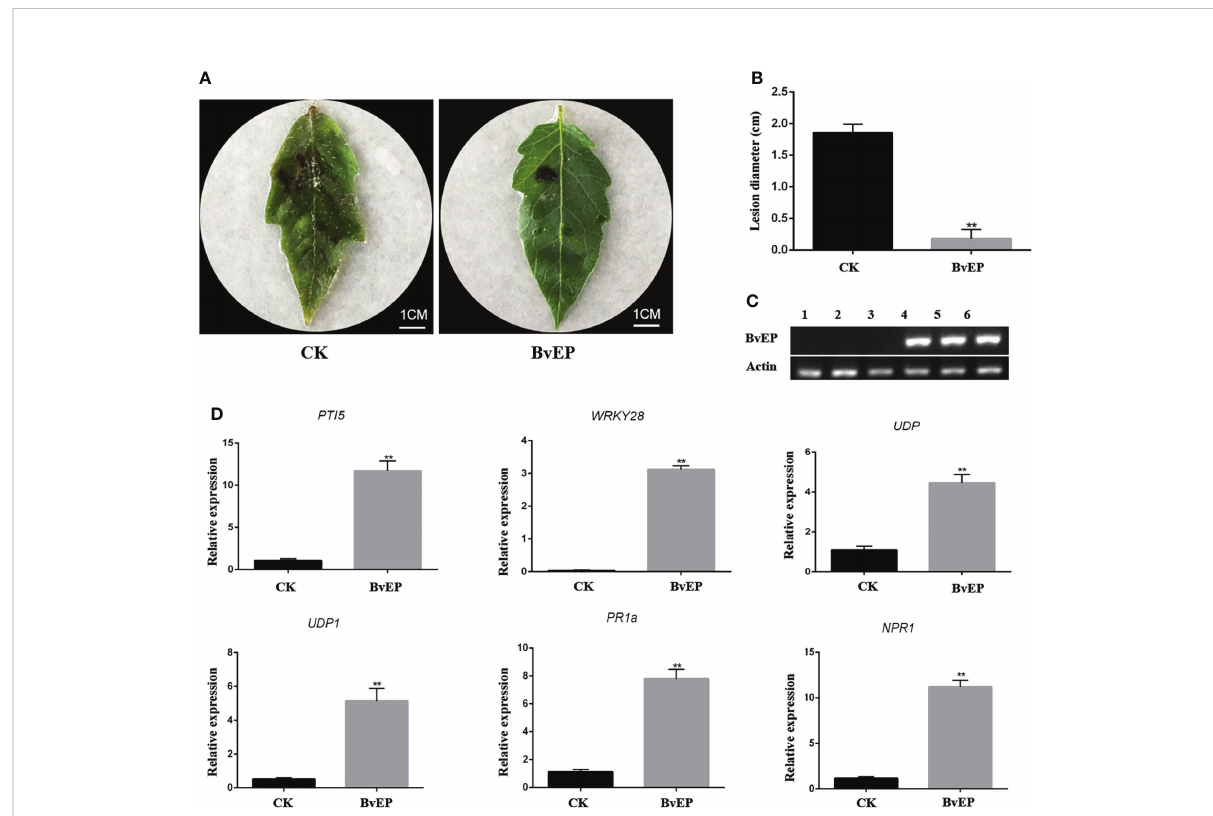
FIGURE 4 Resistance to B. cinerea and expression of disease-resistant genes in transgenic tomato leaves with BvEP overexpression. (A) Phenotype of genetically transformed tomato leaves at 3 DAI with B. cinerea , Figures CK and BvEP are pK7LIC4.0 and pK7LIC4.0-BvEP positive genetically transformed seedlings, respectively; (B) The lesion diameter on tomato leaves at 3DAI with B. cinerea , asterisks indicate statistically signi fi cant differences (** p < 0.01); (C) Expression of BvEP mRNA in transgenic tomato leaves; 1, 2, 3 are pK7LIC4.0 positive genetically transformed seedlings, 4, 5 and 6 are pK7LIC4.0-BvEP positive genetically transformed seedlings; (D) Expression levels of marker genes of resistance pathway in transgenic tomato leaves of pK7LIC4.0 and pK7LIC4.0-BvEP, asterisks indicate statistically signi fi cant differences (** p <